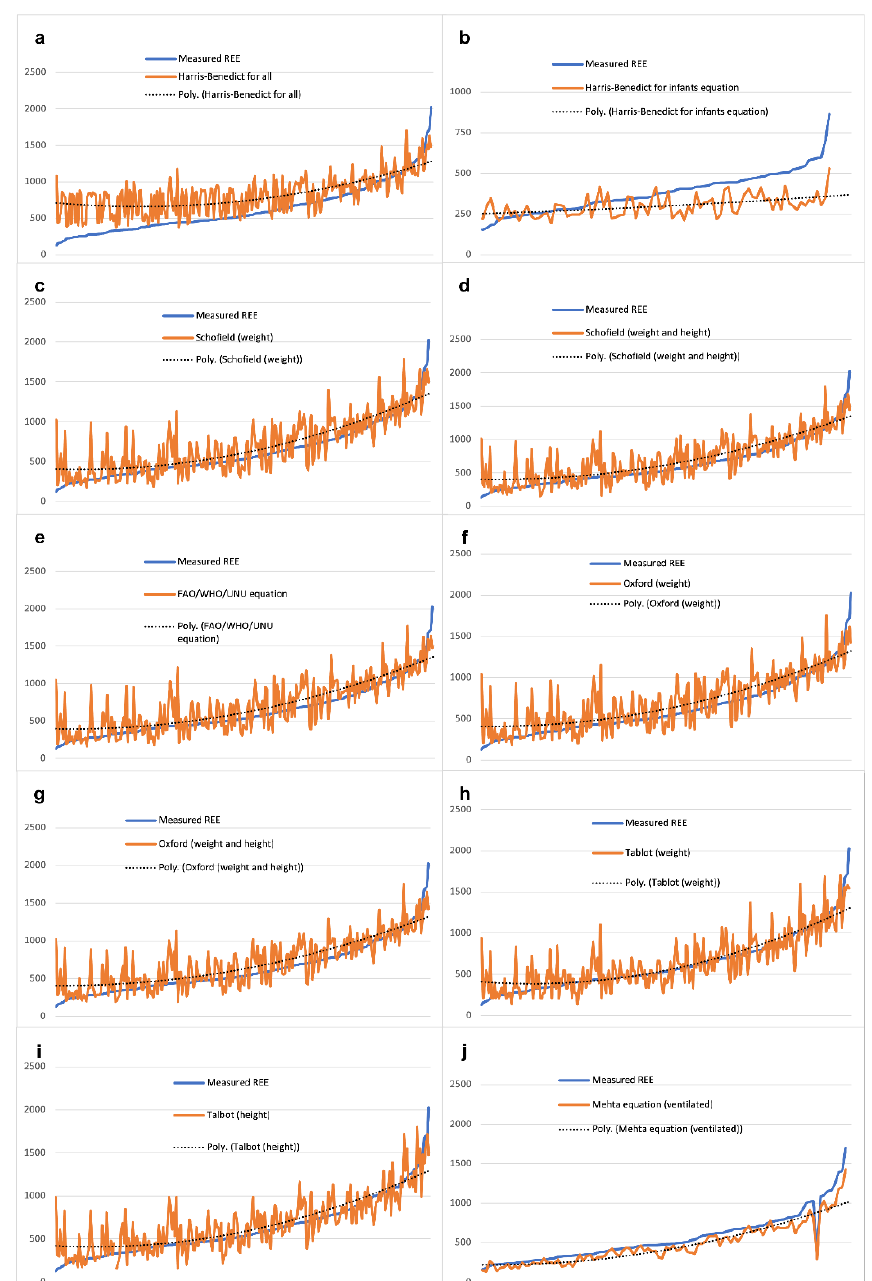
Figure 2. Real REE approximation with predictive equations. Legend Harris – Benedict for all ( a ), Harris – Benedict for infants ( b ), Schofield (weight) ( c ), Schofield (weight and height) ( d ), WHO/FAO/UNU equation ( e ), Oxford (weight) ( f ), Oxford (weight and height) ( g ), Talbot (weight) ( h ), Talbot (height) ( i ), Mehta equation in ventilated children ( j ). All the equations, with the excepti on of Mehta’s, appear to systematically overesti- mate the true REE value and mostly in the left side where true REE reaches the lowest values. The contrary is observed at the extreme right of the graphic, where true REE eval- uations skip over the estimated values (that is, this quite restricted cue may be under- estimated). The most meaningful differences are displayed by the Harris – Benedict equa- tions, even more after adjusting for age <12 months.